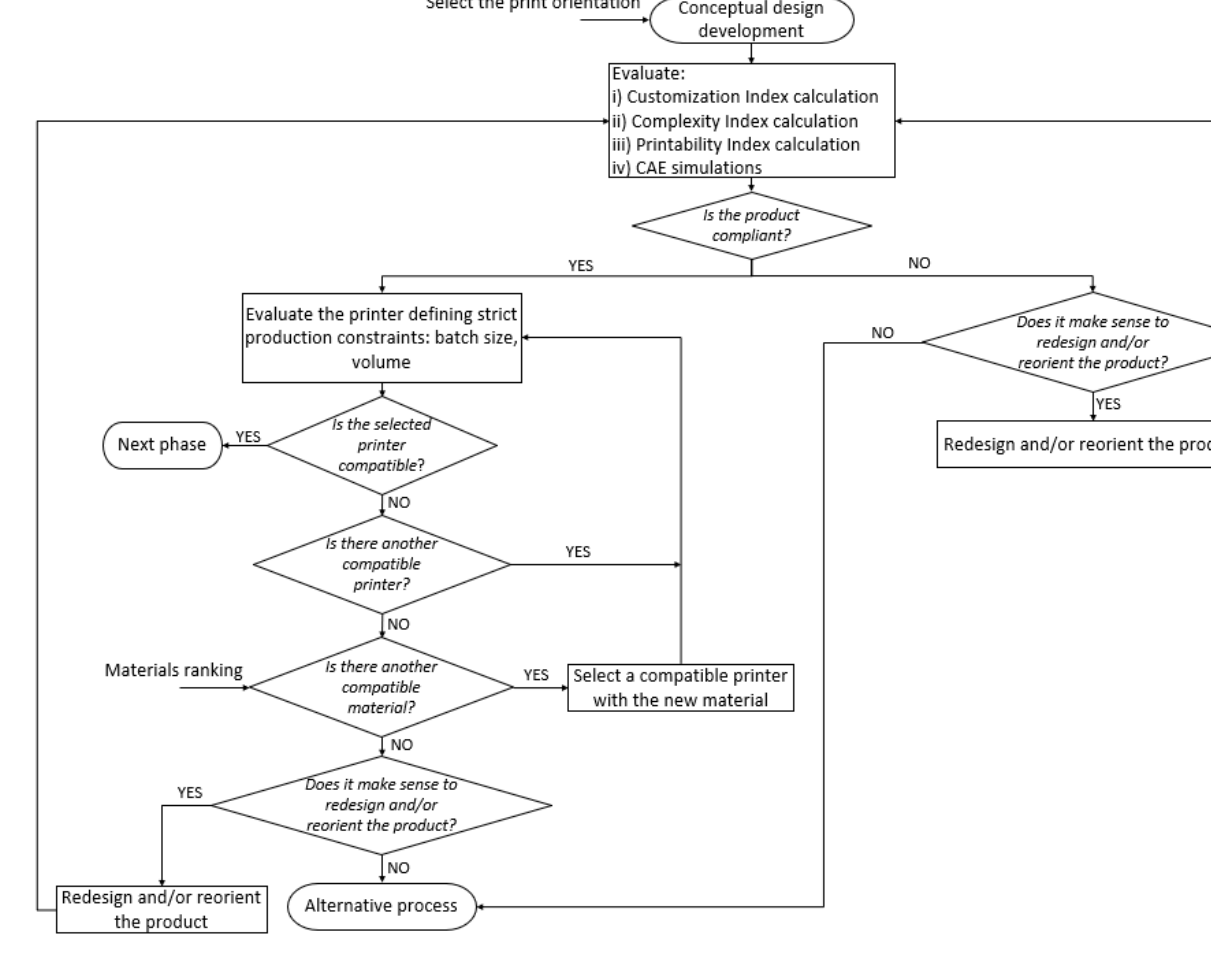
Figure 5. In-depth Analysis.